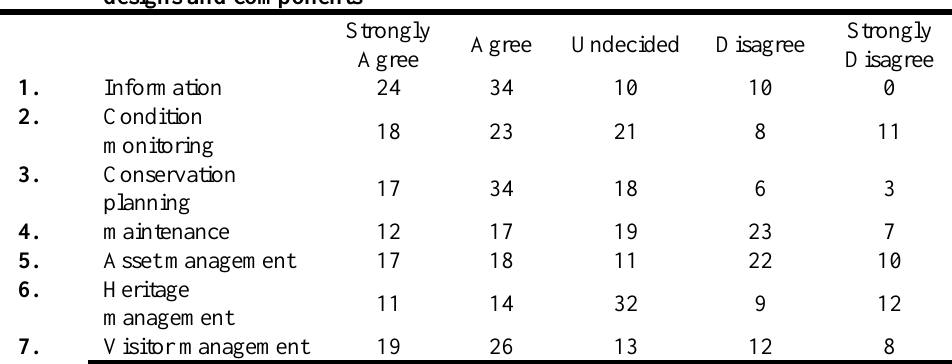
Building Designs and Components (developed by the authors)